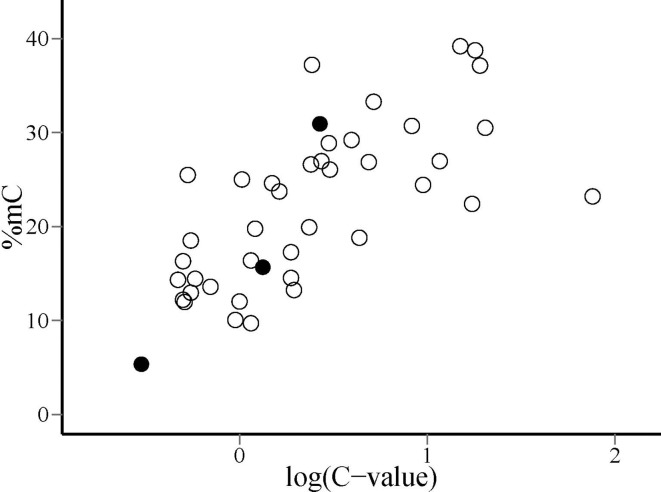
Distribution of species on the plane defined by global DNA cytosine methylation (%mC) and log10-transformed genome size [log(C-value)]. Filled dots indicate, from left to right, the position of Arabidopsis thaliana, Oryza sativa and Zea mays, discussed in the text.